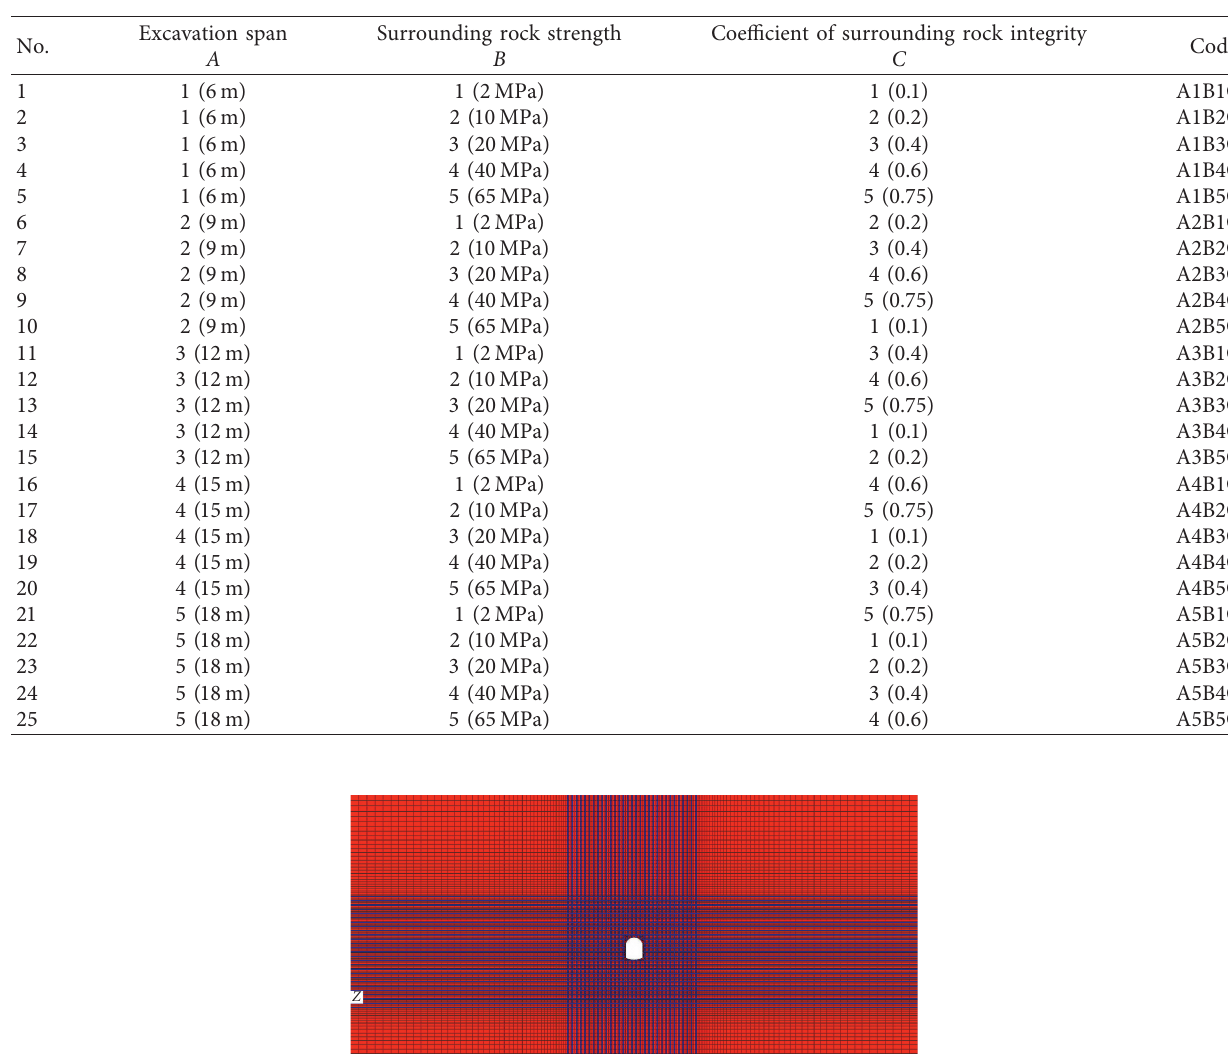
Table 4: Orthogonal test analysis.